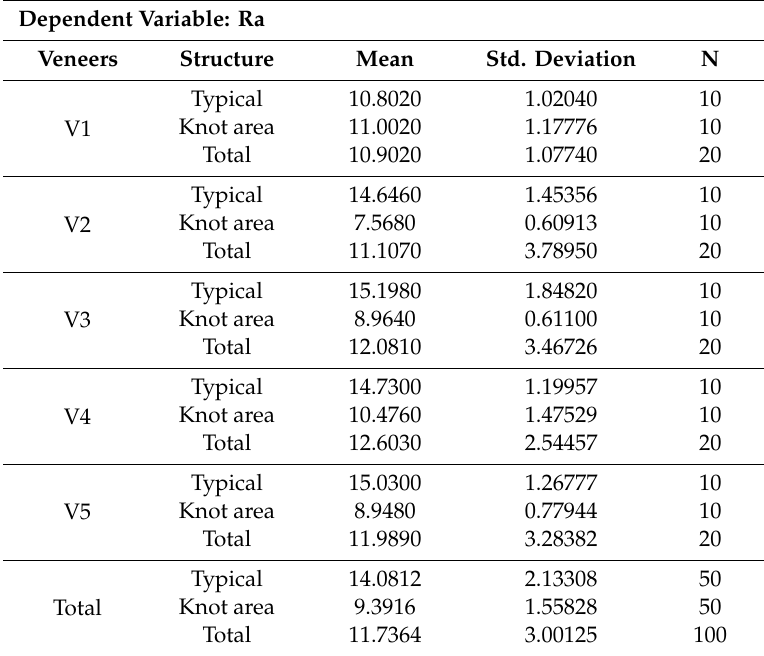
Figure 8. Surface roughness parameters Ra, Rz and Ry (µm) of ash wood veneers (V1–V5) on typical wood structure areas and areas of irregular annual rings and discoloration. Table 3. Descriptive statistics of dependent variable Ra measured on ash veneers of typical and non-typical structure on areas of irregular annual rings and discoloration.